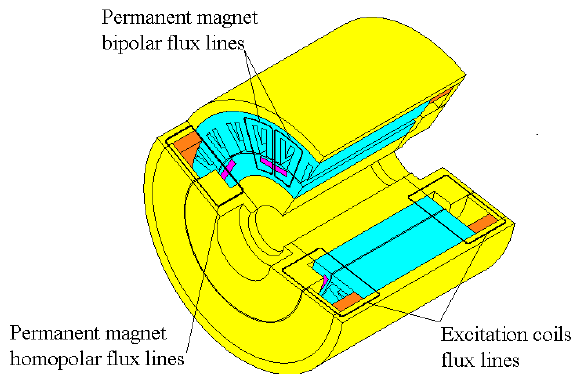
Figure 12. Main magnetic flux paths of the hybrid excitation machine.